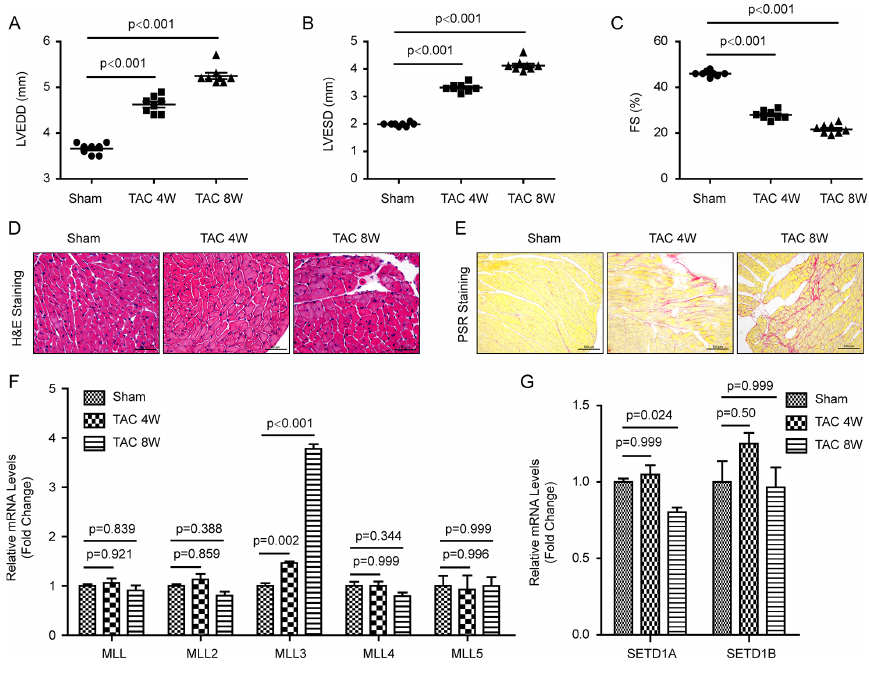
Figure 1. The expression levels of MLL family members in mouse hearts. (A–C) Parameters of echocardiographic results for mice: (A) left ventricular end diastolic dimension; (B) left ventricular end systolic dimension; (C) fractional shortening (n = 8 per experimen- tal group). (D) H&E staining of left ventricle of sham-treated mouse hearts and hearts treated with transverse aortic constriction for 4 or 8 wks (n = 4 mice per experimental group, scale bar 50 μ m). (E) Picrosirius red staining of left ventricles of mouse hearts, red staining indicating collagen deposition (n = 4 mice per experimental group, scale bar 100 μ m). (F,G) Real-time PCR detected mRNA levels of MLL families in mouse hearts (n = 4 mice per experimental